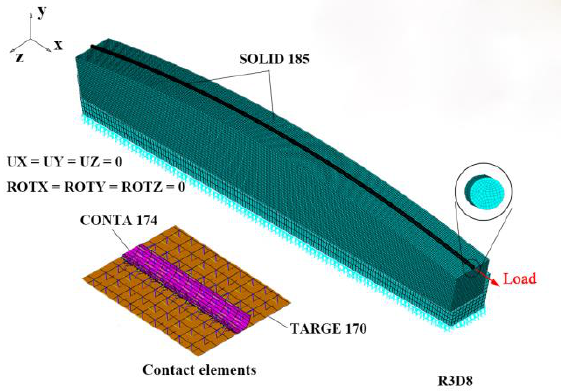
Figure 8. FE model of CFRP tendon and concrete